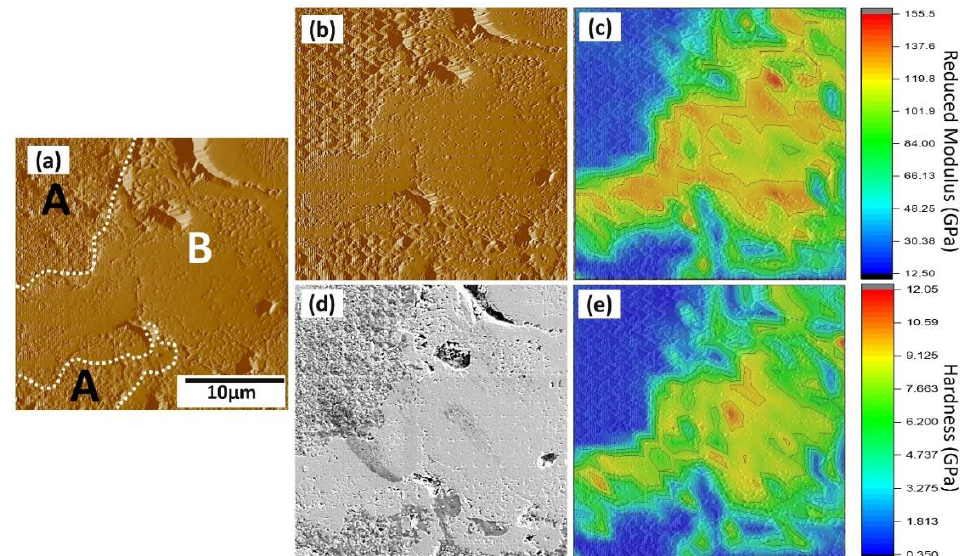
Figure 8. Results of the nanoindentation test of the HAp coating. ( a ) The SPM image of surface before applying the indents; ( b ) and ( d ) the SPM and SEM image of surface after applying the indents; ( c ) and ( e ) property map of reduced modulus and hardness of the coating.